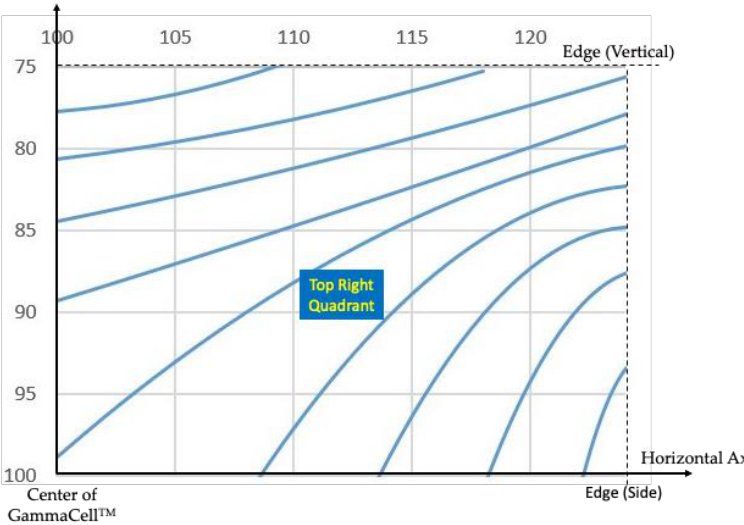
Figure 2. Relative Gamma Dose Map for Nordion GammaCell TM (Data from Ref.